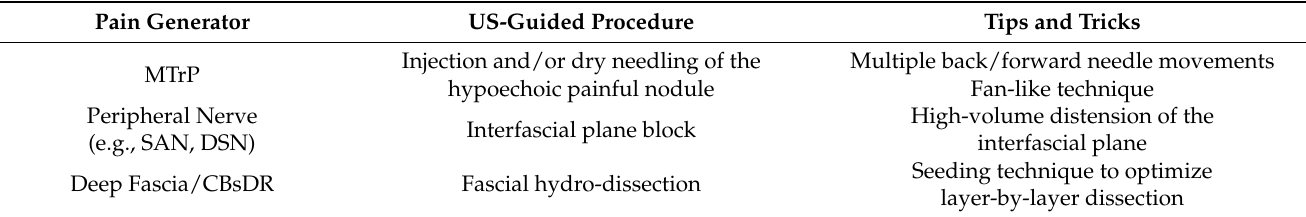
Table 1. Pain generator-based approach for US-guided procedures in cervical